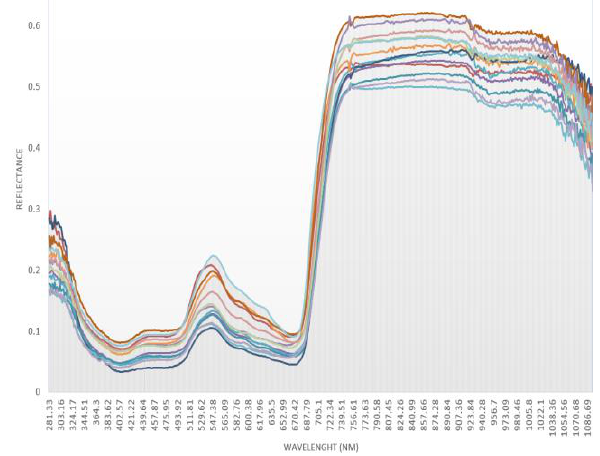
Figure 5. Acquired reflectance from the numerous field Figure 4. The Nemea study area with few of the Agiorgitiko observations over Agiorgitiko vines in the Nemea study vineyards.